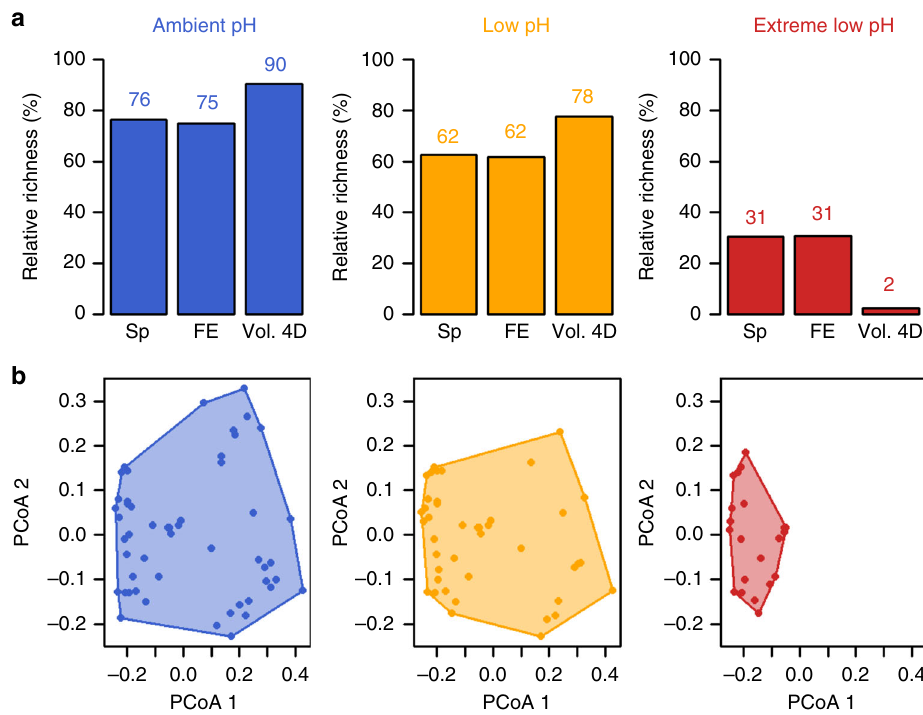
Fig. 1 Species and functional diversity changes among pH zones. a Barplots show species richness (Sp), number of functional entities (unique trait combinations, FE) and functional richness (volume fi lled by each assemblage in the four dimensions of the functional space, Vol. 4D). Values are expressed as a relative percentage of the value for the total pool and are displayed above the bars. b Functional space fi lled by the functional entities (FEs) present in species assemblages from each pH condition. Axes (PCoA1 and PCoA2) represent the fi rst two dimensions of the 4D functional space. Principal coordinate analysis (PCoA) was computed on functional-trait values. Number of species = 72; number of FEs =